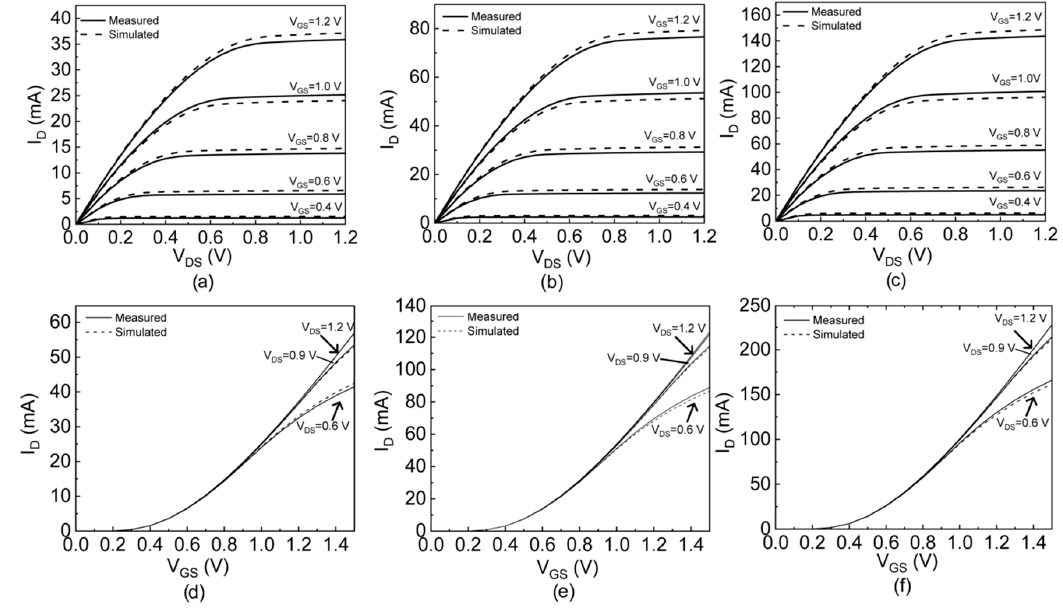
Figure 6. Simulated and experimental output and input characteristics for ( a , d ) ( W / L ) eq = 47.5 W / L , ( b , e ) ( W / L ) eq = 95 W/L , and ( c , f ) ( W / L ) eq = 190 W/L .